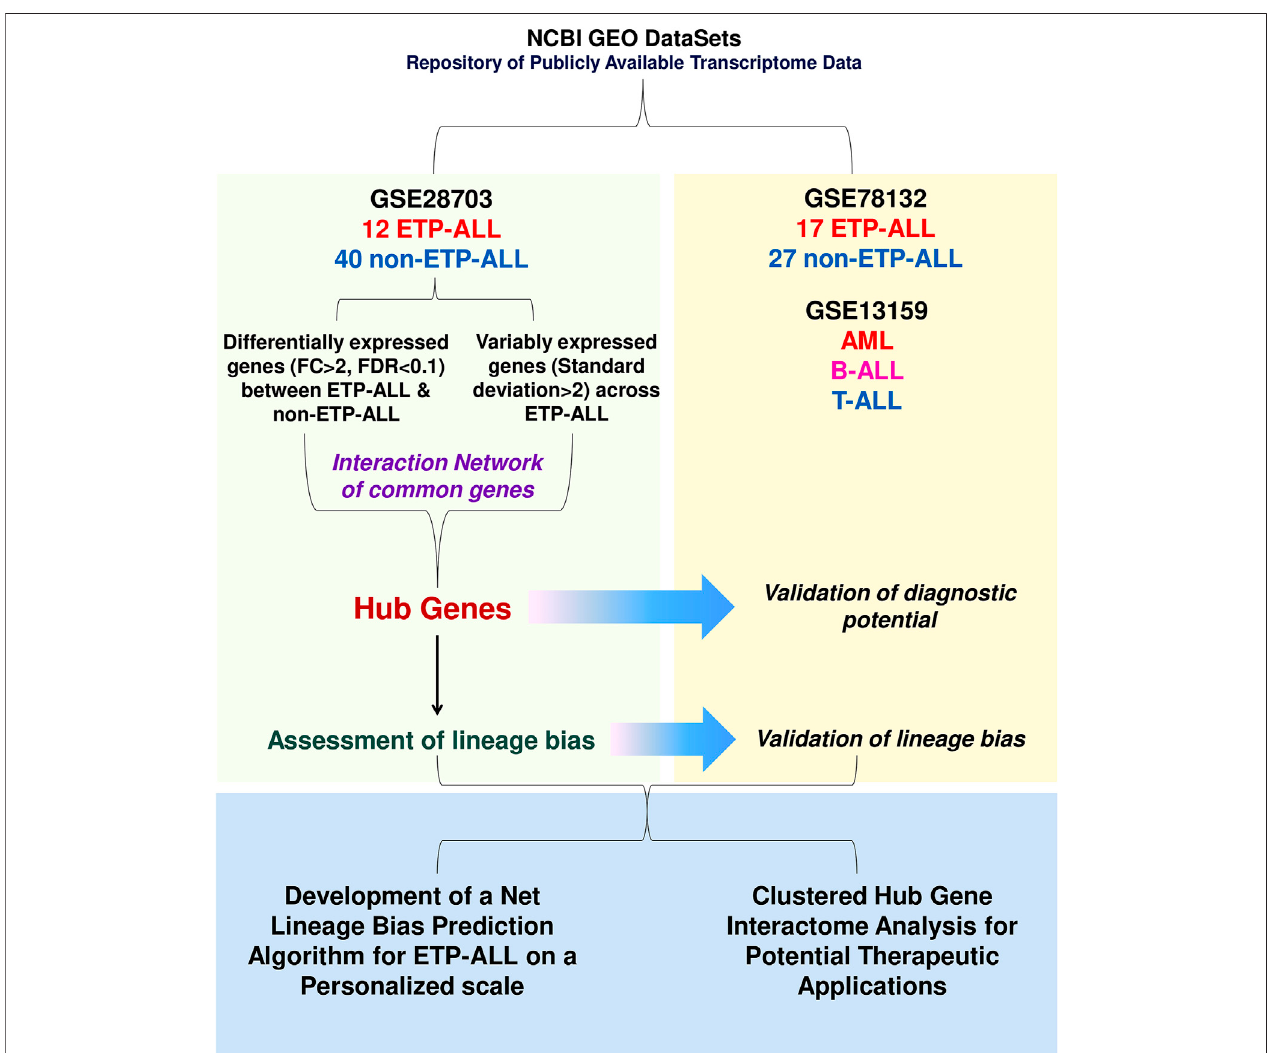
FIGURE 1 | Diagrammatic representation of the work- fl ow. The entire work lies on three segments: discovery of transcriptomic signatures from the GSE28703 dataset, validation of the proposed signatures in the GSE78132 (and GSE13159 in some cases) datasets and amalgamation of the validated fi ndings in order to identify potential lineage-directed diagnostic and therapeutic implementations against